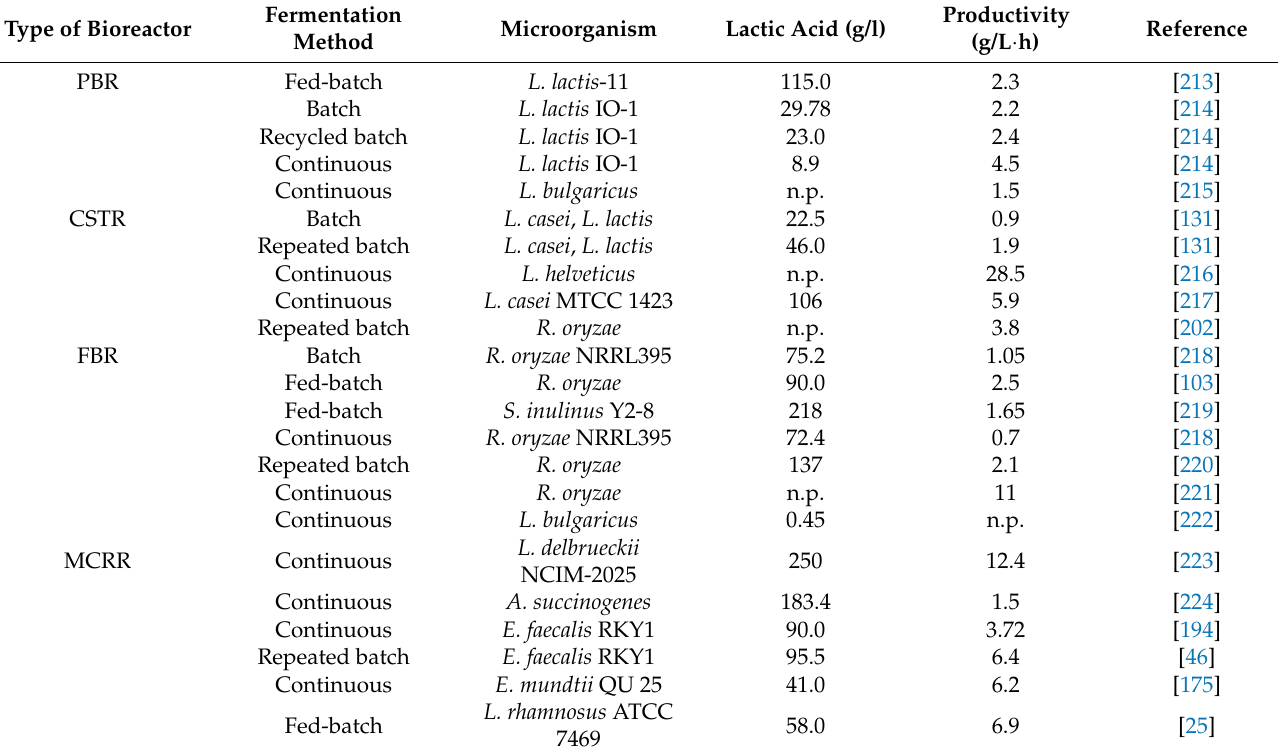
Table 3. Lactic acid fermentation using the advanced bioreactors with high cell